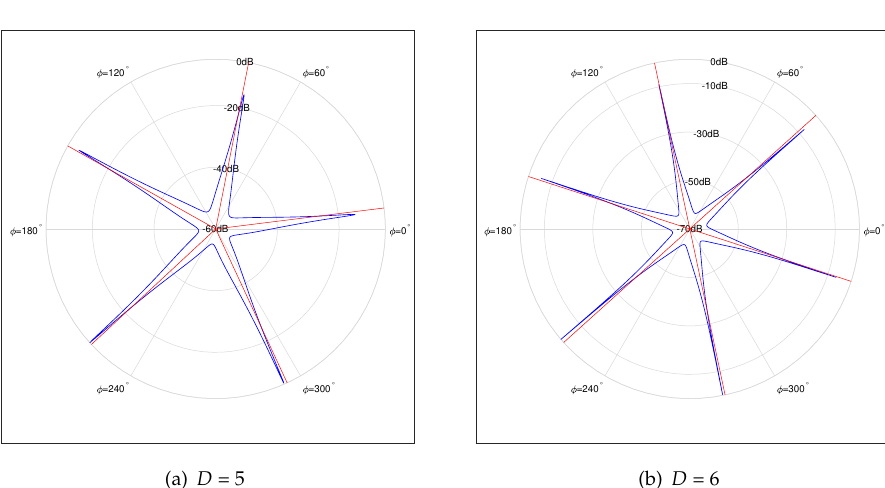
Figure 6. RMSE of 5 and 6 Sources, ( N = 7, N p = 5).